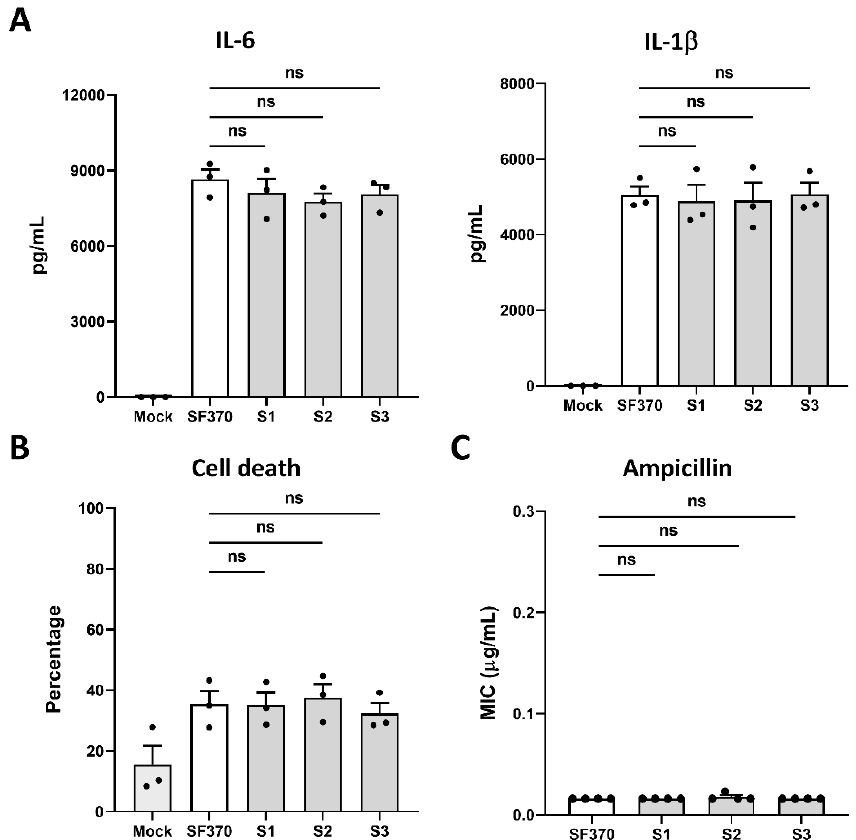
Figure 4. Phage A1-surviving strains do not influence host immune responses or antibiotic tolerance compared to wild type. ( A ) Overnight cytokine production by BLaER1 cells after infection with WT S. pyogenes SF370 and phage-surviving strains. ( B ) The percentage of BLaER1 cell death after infection with Phage A1 survivors or WT S. pyogenes SF370 is shown. ( A , B ) Mock: buffer control, S1: phage survivor 1, S2: phage survivor 2 and S3: phage survivor 3; ( C ) Ampicillin susceptibility profiles of S. pyogenes SF370 and survivor strains are shown. S1: phage survivor 1, S2: phage survivor 2 and S3: phage survivor 3; (A–C) Pooled data from three or four independent experiments are shown. Statistical significance between groups was determined by one-way ANOVA tests.